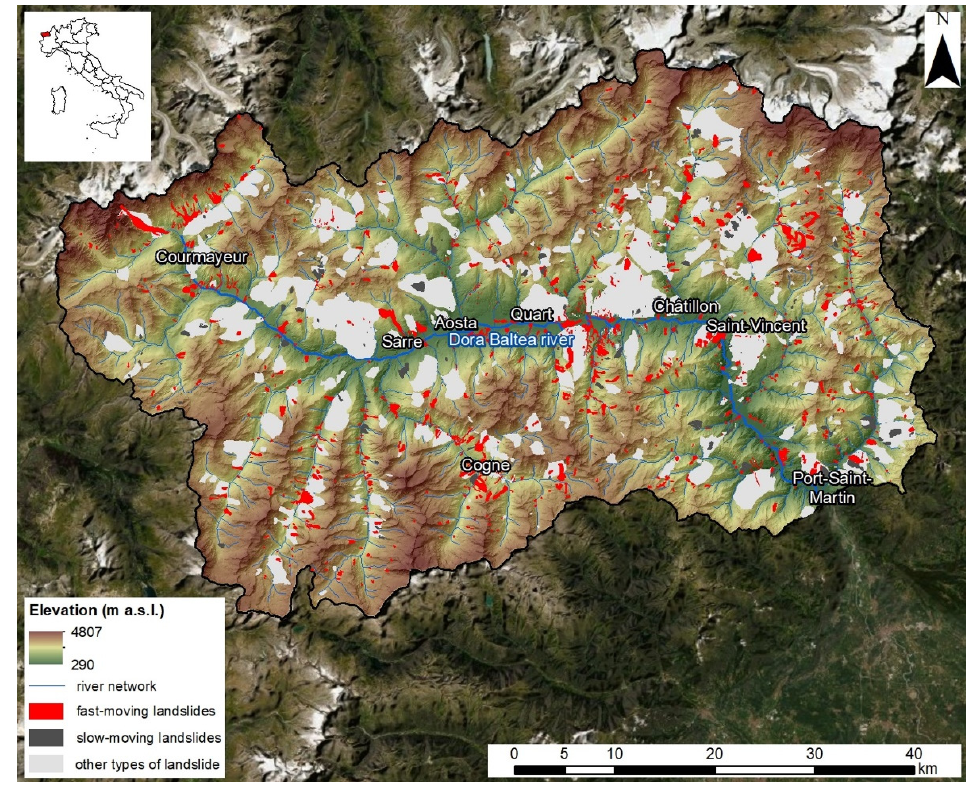
Figure 2. Digital elevation model of the study area with overlapping Dora Baltea River network and the IFFI landslide inventory [30,31].